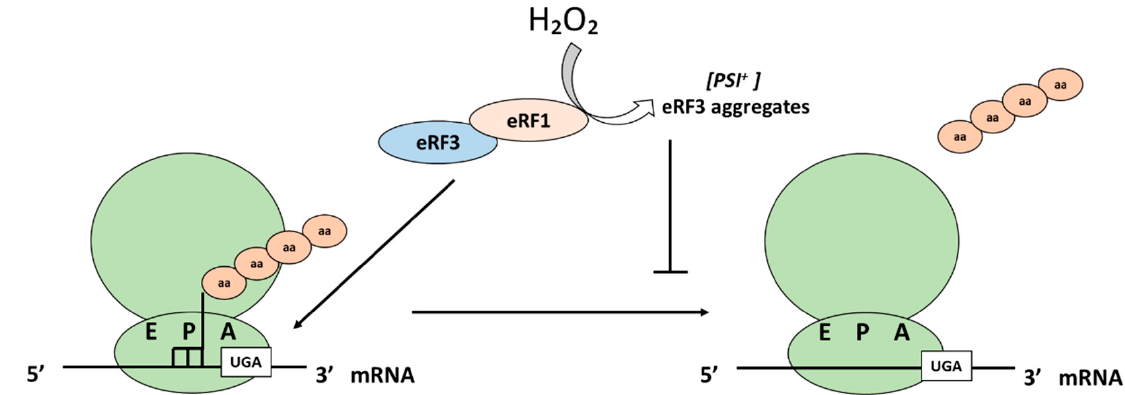
Figure 5. Effect of H 2 O 2 on translation termination. Eukaryotic release factor 3, eRF3, forms prion aggregates known as [PSI + ] under H 2 O 2 conditions and can no longer perform its normal function in translation termination, leading to an elevated readthrough of termination codons.